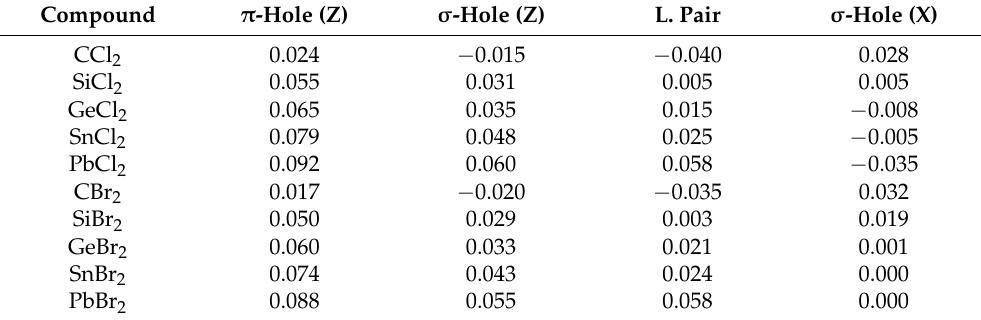
Table 1. The values of electrostatic potential, EP (in au), for dihalometallylenes; the results of sponding to the location of the lone electron pair, the EP values at the σ -hole and π -hole sites of the tetrel (Z) and halogen (X) centers are given (see Scheme 1).